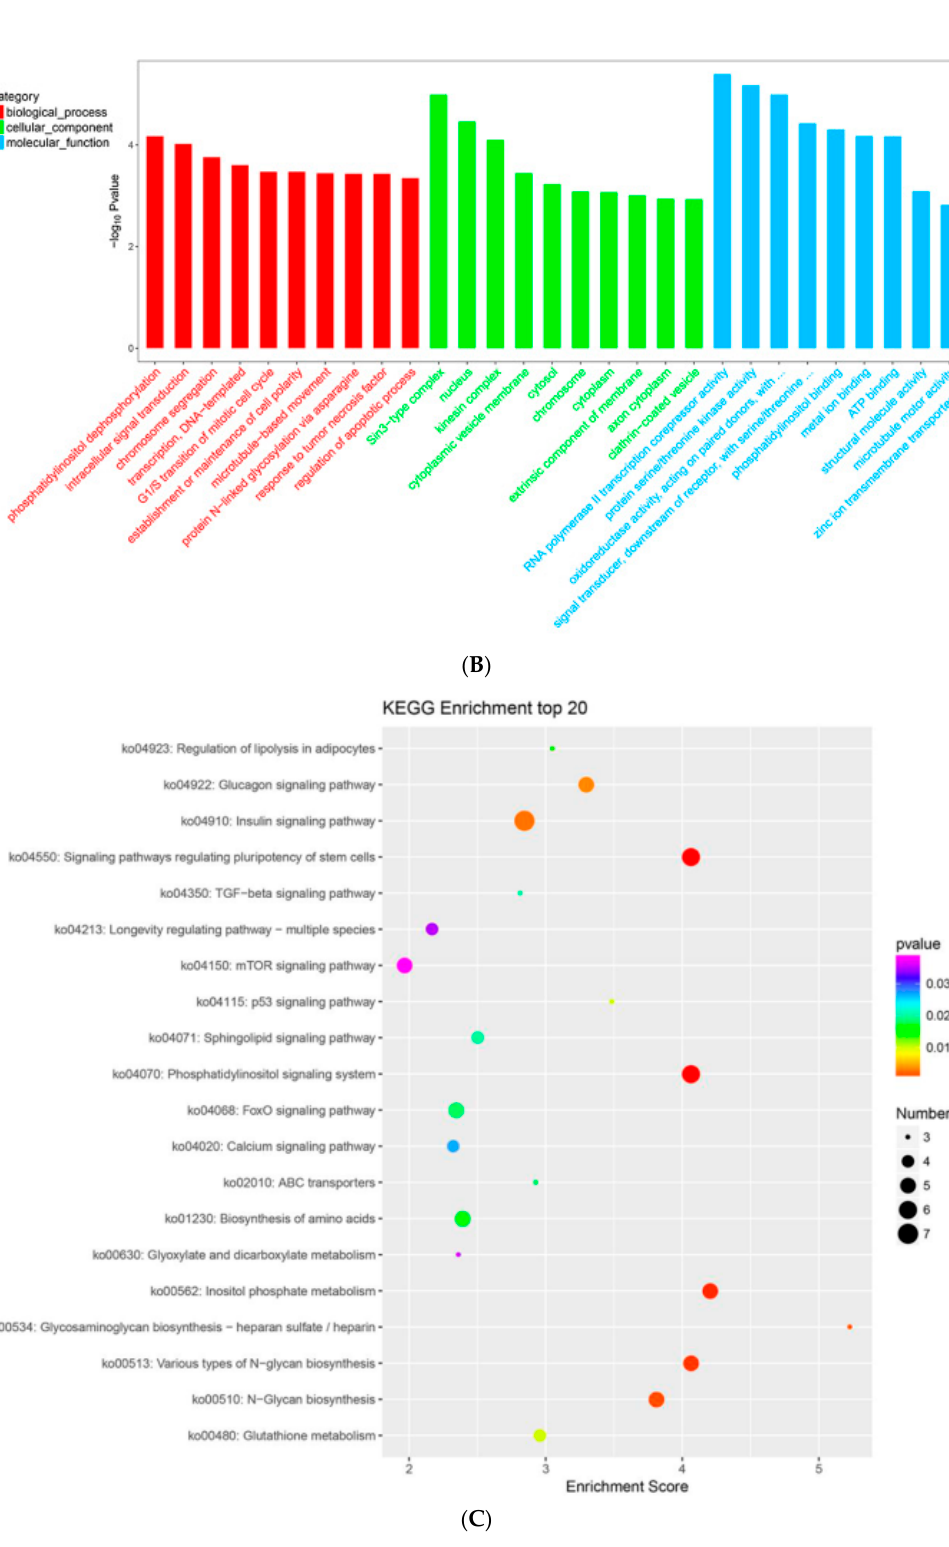
Figure 8. Distribution and functional enrichment analysis of significant differences in methylation and expression levels in methylome- and transcriptome-associated genes (MTGs). The distribution of MTGs in four different quadrants; the number in each quadrant refers to the number of MTGs in that quadrant ( A ). MTGs were classified into cellular components, molecular function and biological processes by WEGO according to GO terms ( B ). KEGG pathway enrichment of MTGs. The circle size represents gene numbers, and the colour represents the Q value ( C